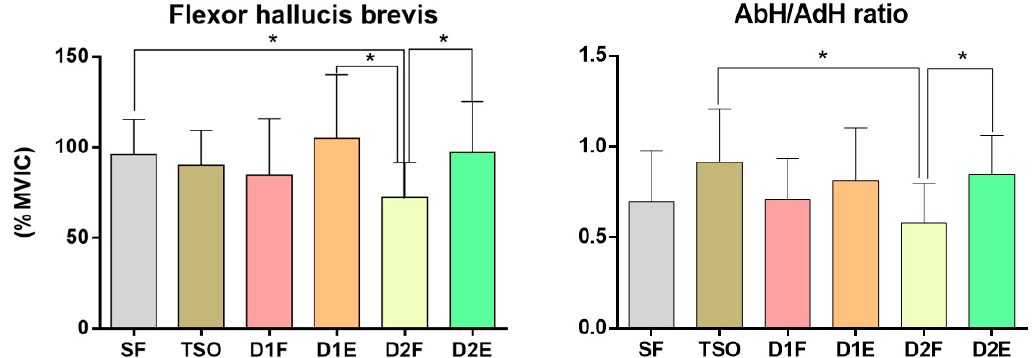
Figure 7. Comparison of the activation of abductor hallucis and extensor hallucis longus during foot–ankle exercises. * p < 0.05.